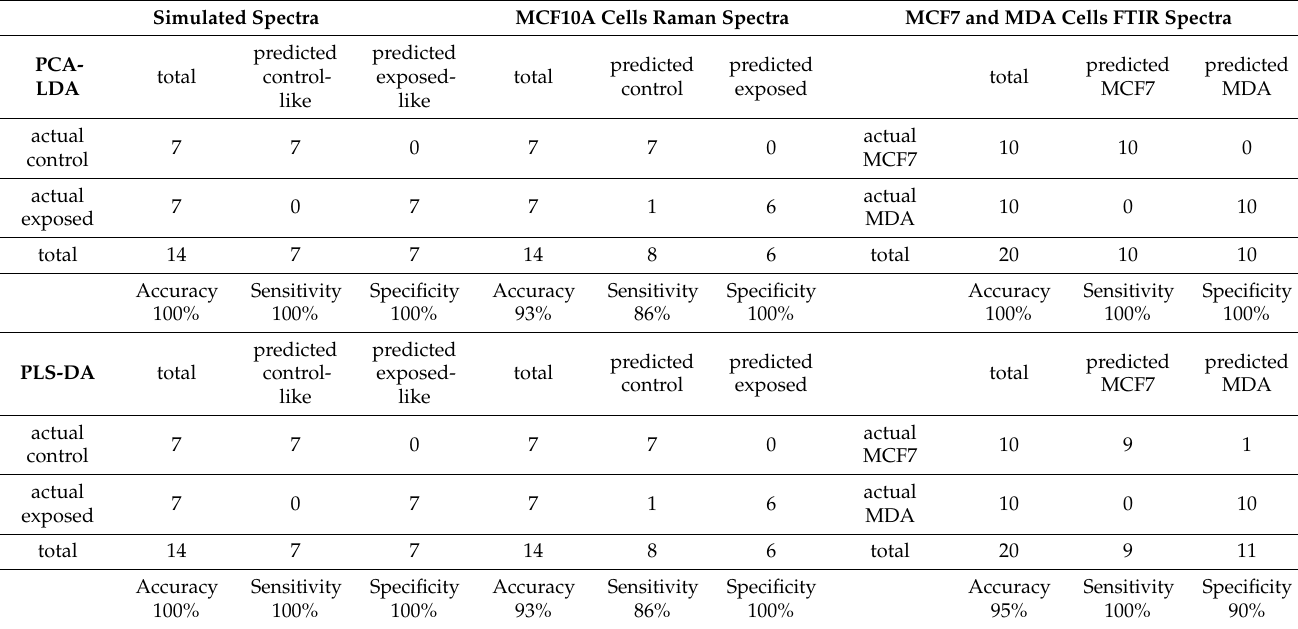
Table 1. Performance parameters for the three types of spectra. The parameter values are estimated by considering the results obtained for the spectra of the test sets. Accuracy represents the total rate of spectra correctly classified; sensitivity is the rate of spectra classified as exposed-like (for simulated spectra), exposed (for Raman spectra) and metastatic MDA (for FTIR spectra) with respect to the spectra which refer actually to exposed-like, exposed and MDA samples, respectively; specificity is the rate of spectra classified as control-like (for simulated spectra), control (for Raman spectra) and non-metastatic MCF7 (for FTIR spectra) with respect to the spectra which refer actually to control-like, control and MCF7 samples,